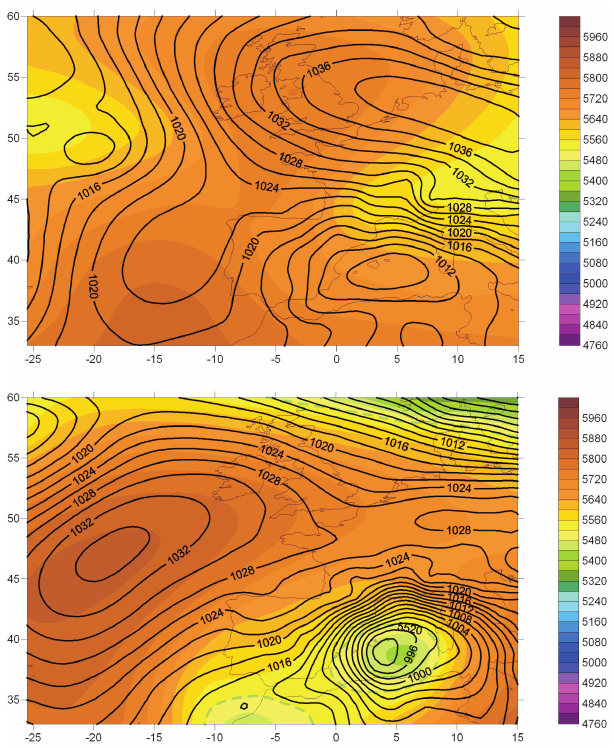
Fig. 9. SLP (lines) and Z500 (colours) during an MC situation. Top: 28/10/1997 at 12:00UTC; bottom: 11/11/2001 at 06:00UTC, map from ERA-Interim reanalysis done by European Centre for Medium Weather Forecast (ECMWF).